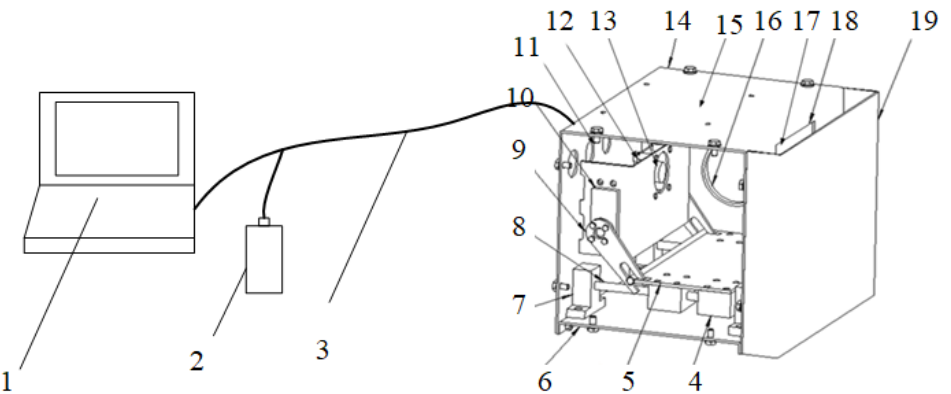
Figure 1. Online detection device for wheat impurity content in mechanized harvesting. (1 computer; 2 12-V DC power supply; 3 system bus; 4 sliders; 5 telescopic plates; 6 bases; 7 rail seats; 8 rails; 9 levers; 10 DC servos; 11 data bus connectors; 12 industrial cameras; 13 Industrial camera fixing bracket; 14 shell; 15 embedded data processing module; 16 LED visual light source; 17 transparent plexiglass; 18 photo window; 19 sampling chamber.)